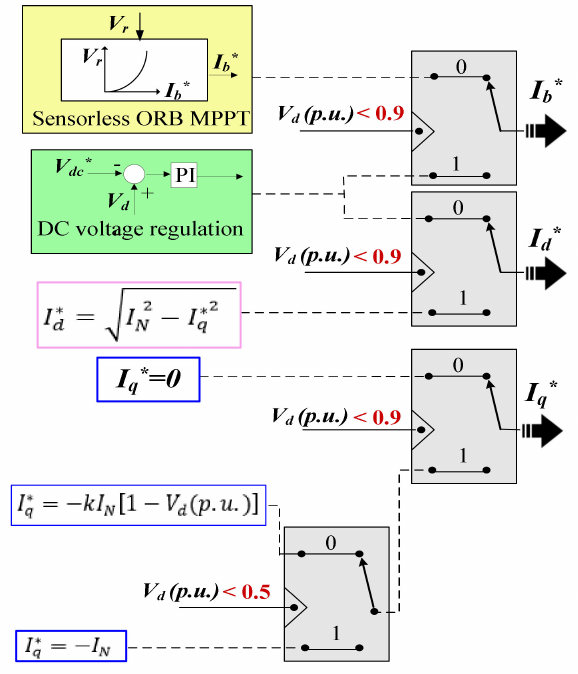
Figure 6. Reference generation for system converters’ controllers during normal operation and grid voltage